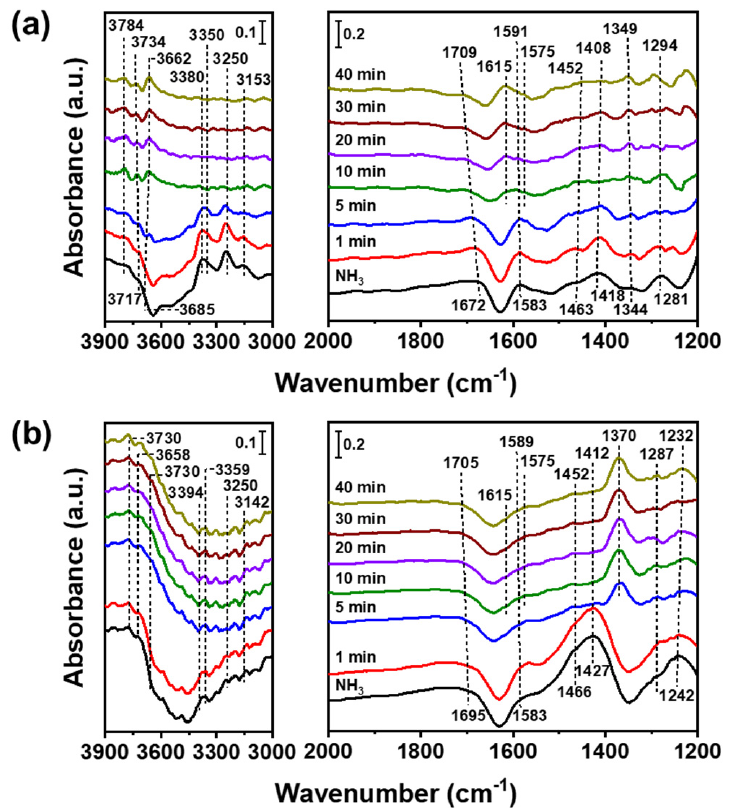
Figure 6. In situ Fourier-transform infrared spectra of nitrogen oxide and oxygen reacted with pre-adsorbed ammonia over (a) V 2 O 5 (IM)–WO 3 (IM) and (b) V 2 O 5 (P)–WO 3 (P) at 200 °C. Conditions: [NO] = 500 ppm (when used), [O 2 ] = 5 vol.% (when used), and N 2 as the balance.